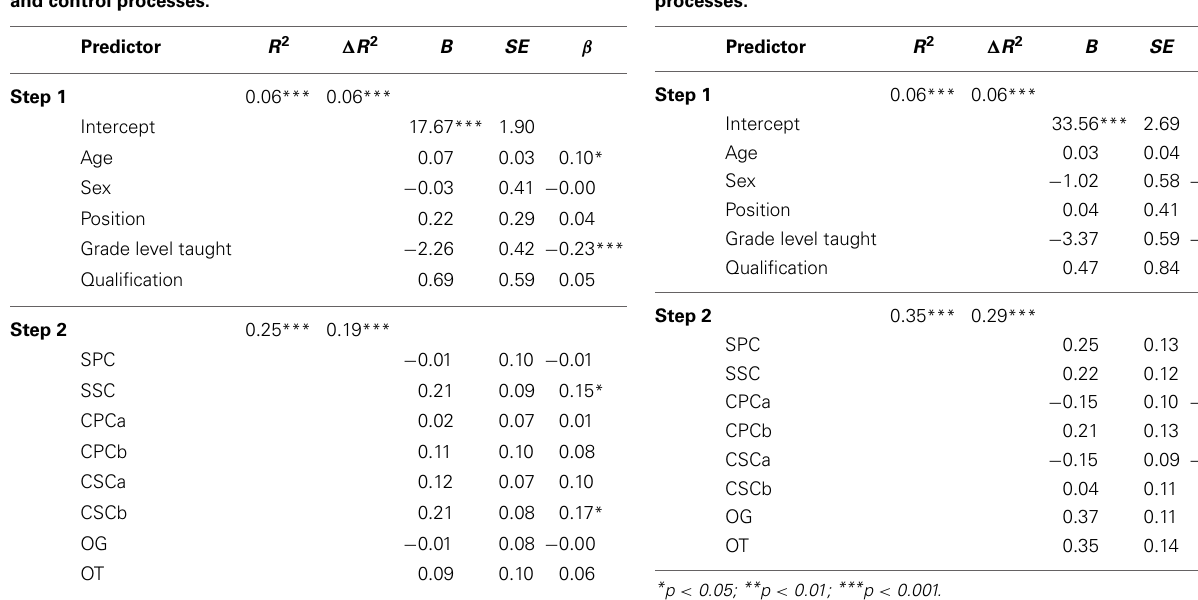
Table 7 | Summary of hierarchical multiple regression analysis predicting subjective vitality from demographic variables and control